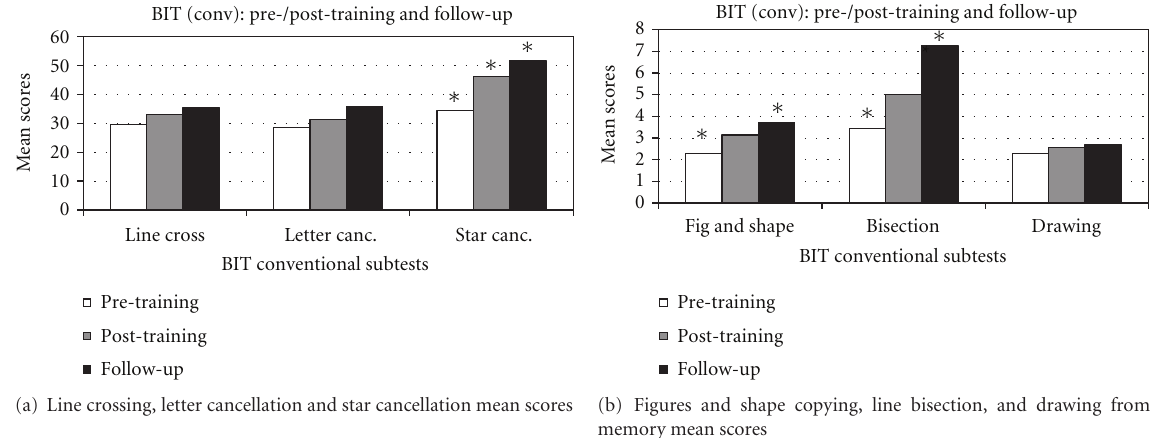
Figure 2: BIT conventional subtests scores in the pre-/post-training and in the follow-up evaluation. ∗ Significant value.